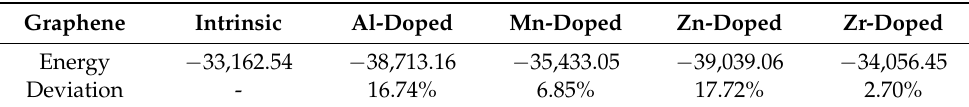
Table 2. Bond lengths of the C–C, Al–C, Mn–C, Zn–C, and Zr–C in three directions (B1, B2, and B3) before and after the interactions (unit: